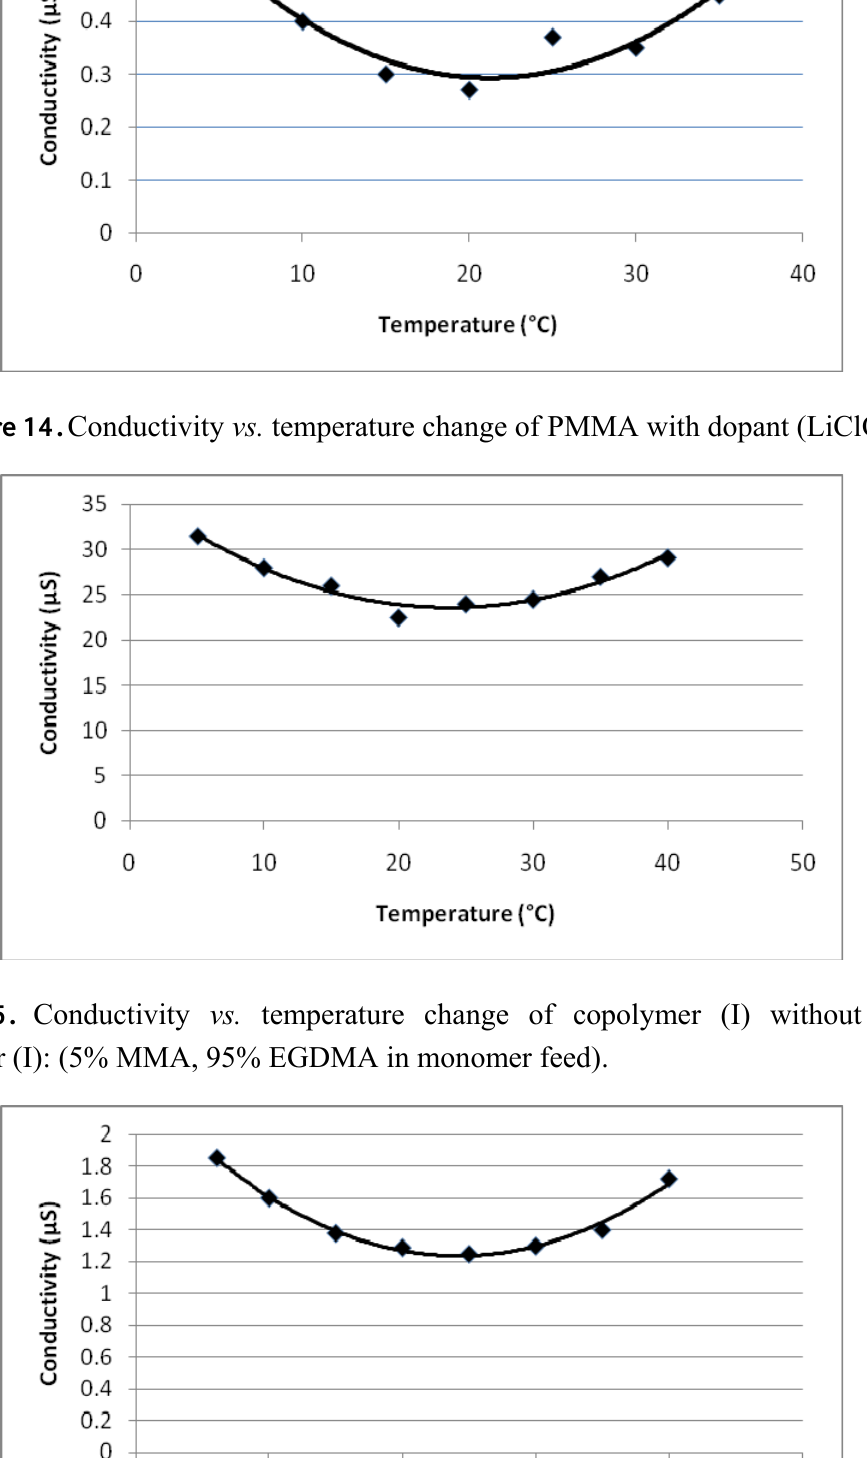
Figure 13. Conductivity vs. temperature change of PMMA without dopant.